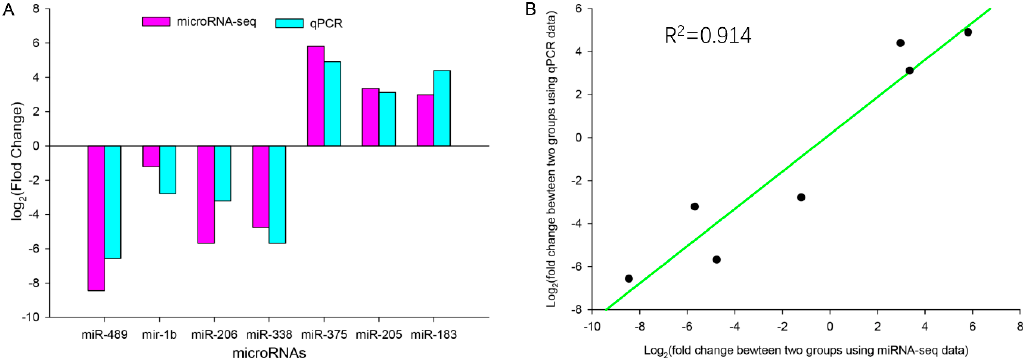
Figure 4. Validation of the genes miRNA expression patterns obtained from miRNA-seq data using qRT-PCR. ( A ) Assessment of Log2FC (fold changes (FC)) using the RNA-seq data and qPCR data for seven selected miRNAs. ( B ) The Relationship of Log2FC between both the high and low backfat groups using the RNA-seq data and qRT-PCR data ( p < 0.05).